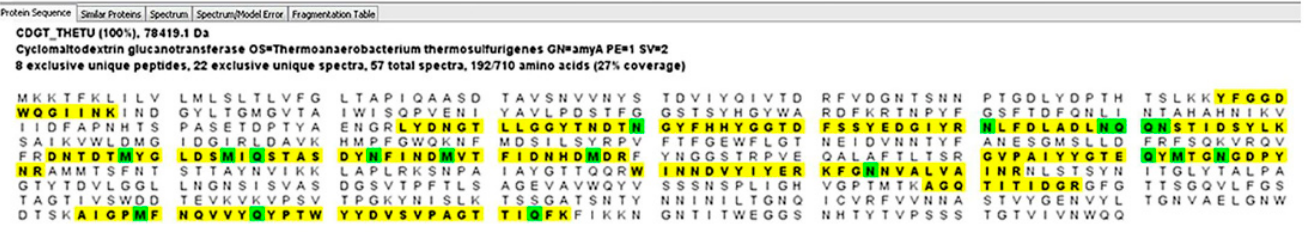
Figure 5 . Identification of a CGTase in aroma from the liquefied pudding. Yellow-labeled sequences, covering 27% of the CDGT_THETU sequence, were identified.